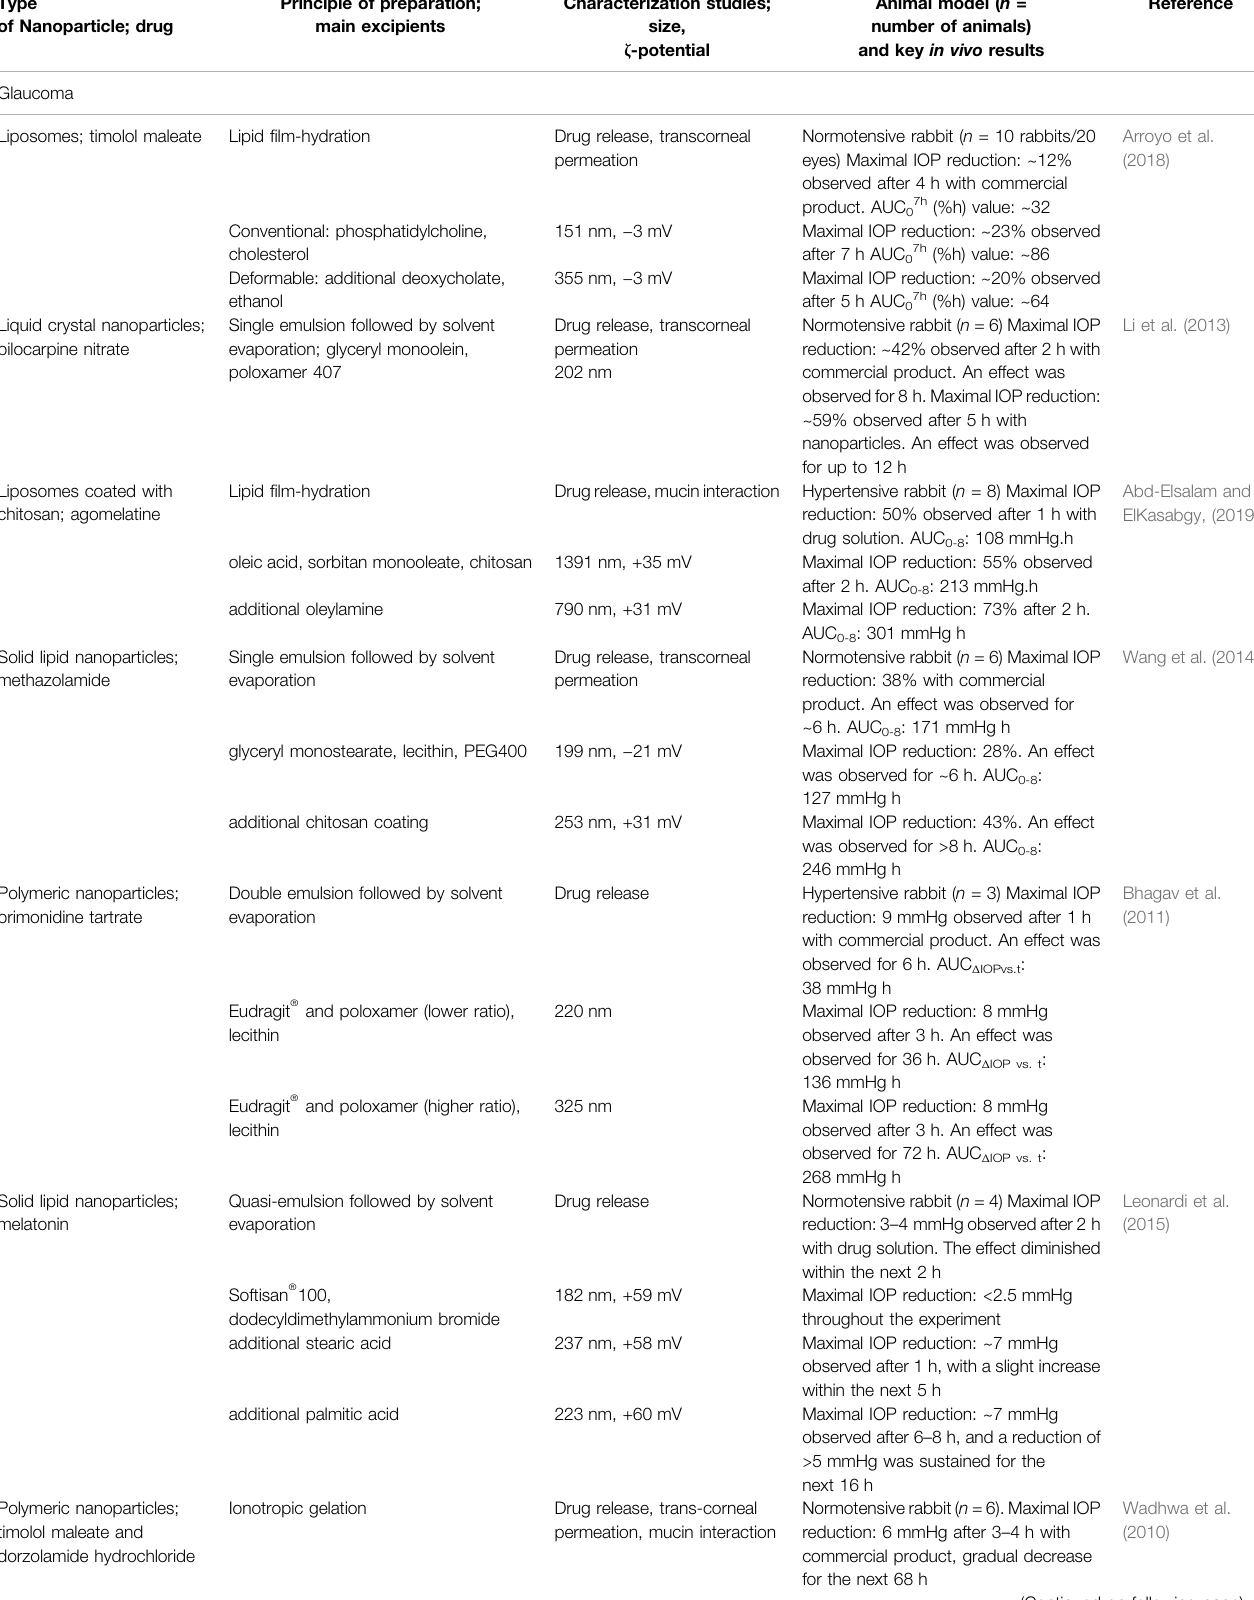
TABLE 4 | Summary of in vivo studies on nanoparticle-based systems used for drug delivery to anterior segment of the eye. Type of Nanoparticle;